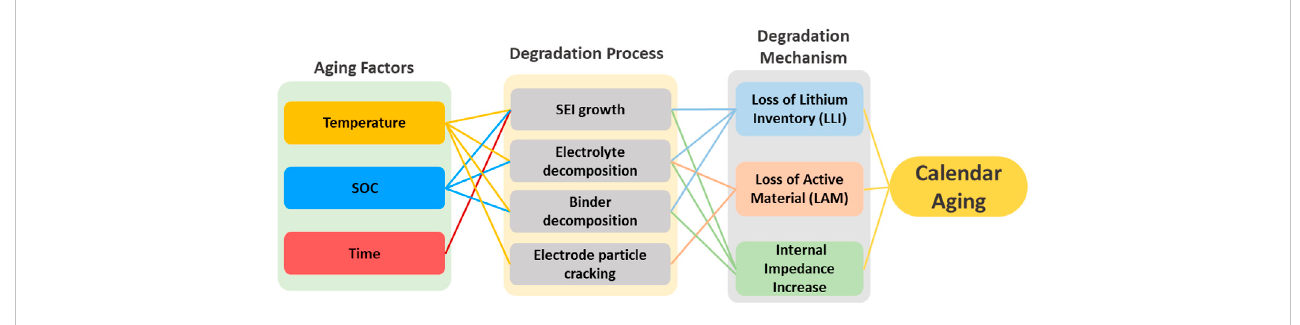
FIGURE 1 Overview of the factors accelerating the overall calendar aging rate (Birkl et al., 2017; Kabir and Demirocak, 2017; Li et al., 2019; Li et al.,